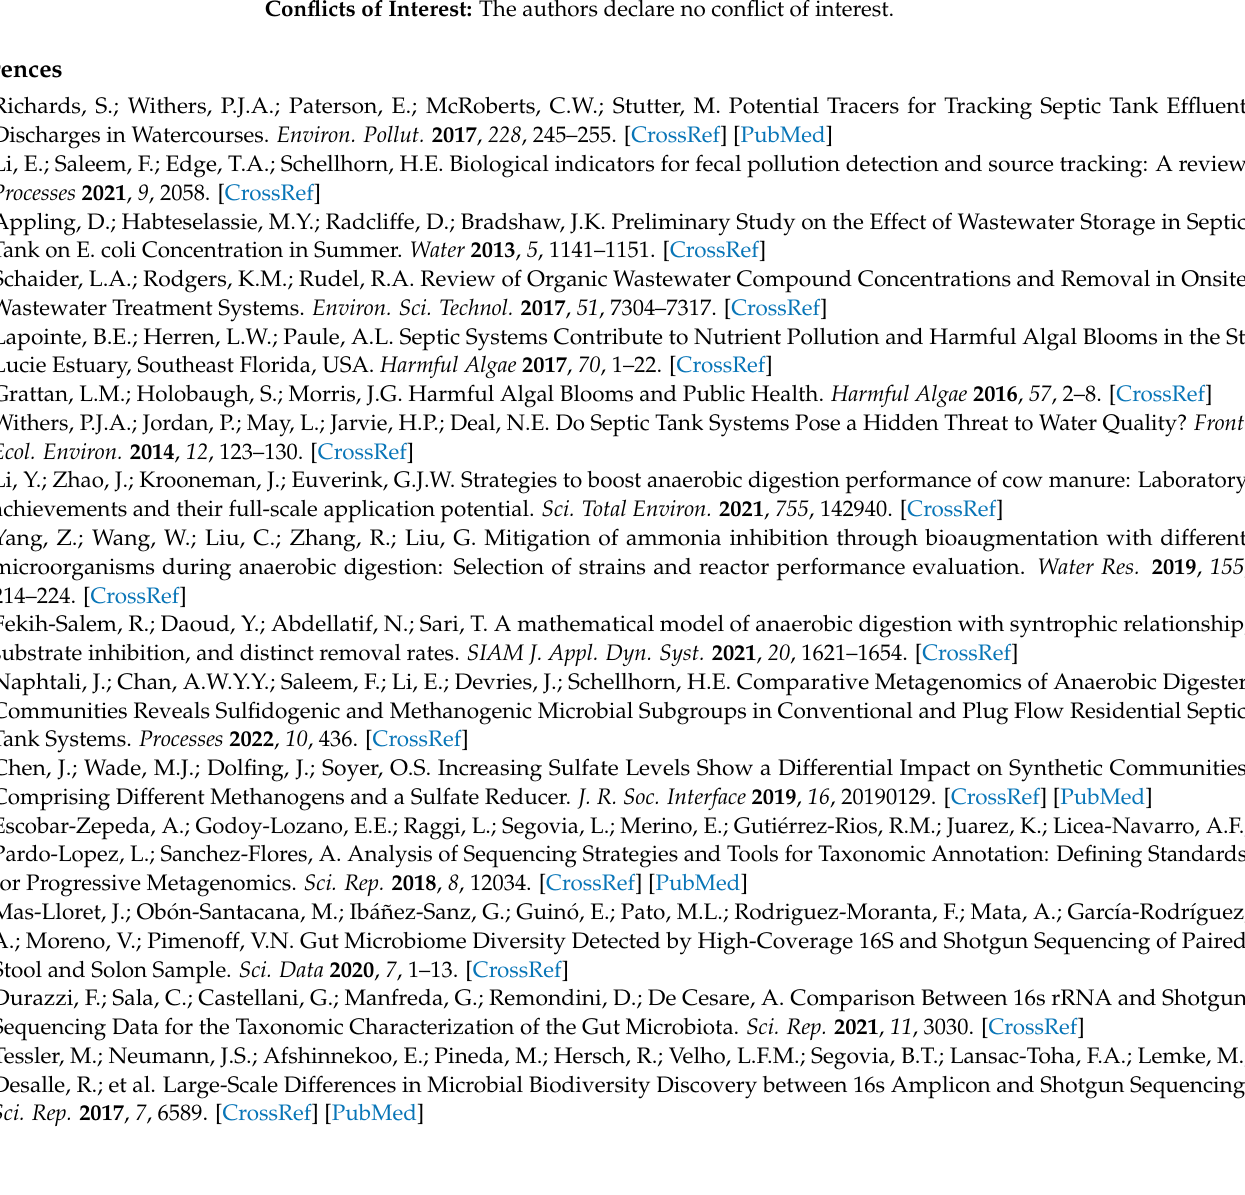
Table S5: 16S Core Microbiome; Table S6: Both Methods Core